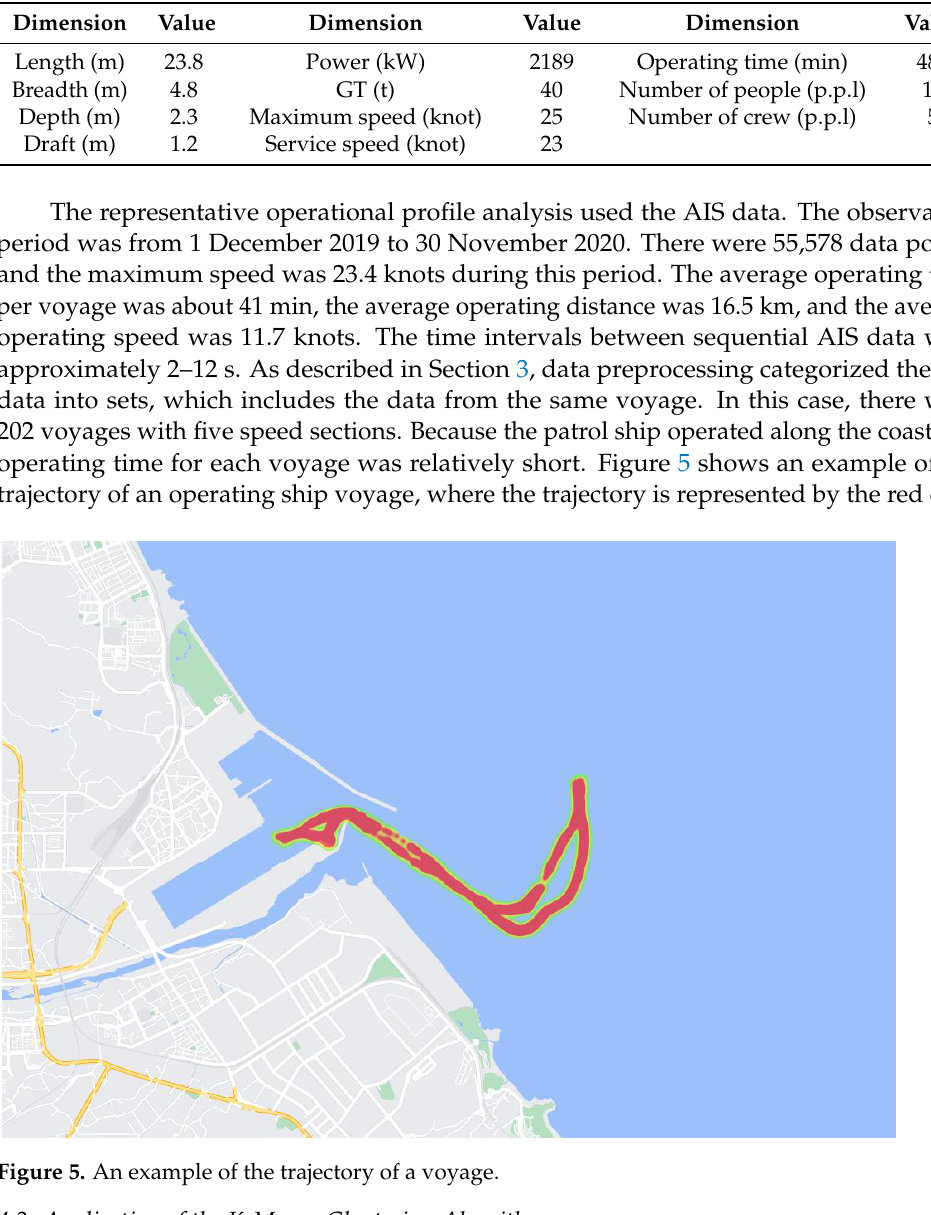
Table 2. Principal dimensions of a patrol ship.